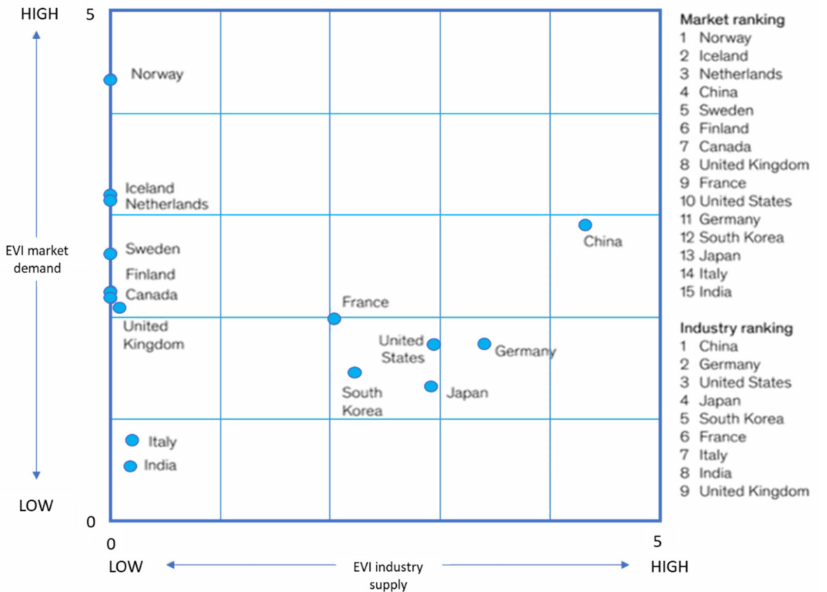
Figure 2. Overall Electric Vehicle Index (EVI) results, score (range from low of 0 to high of 5) [12].